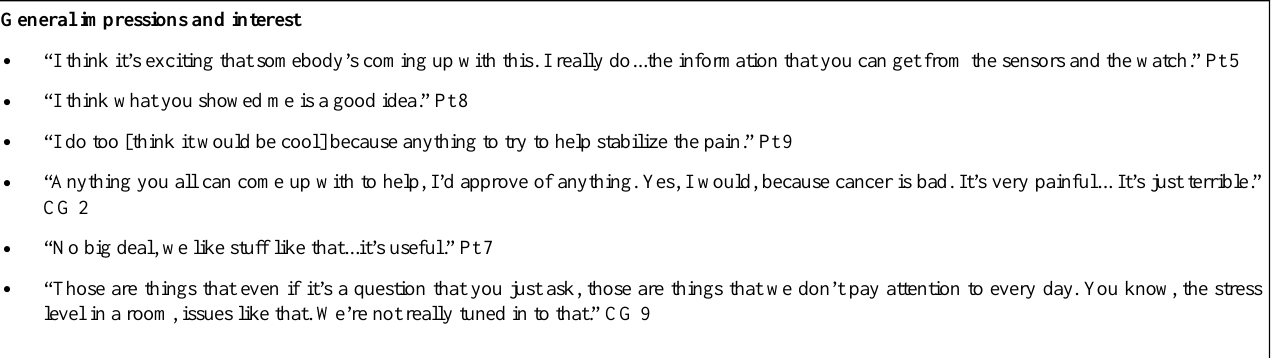
Textbox 2. Feedback from patients and caregivers regarding the Behavioral and Environmental Sensing and Intervention for Cancer system